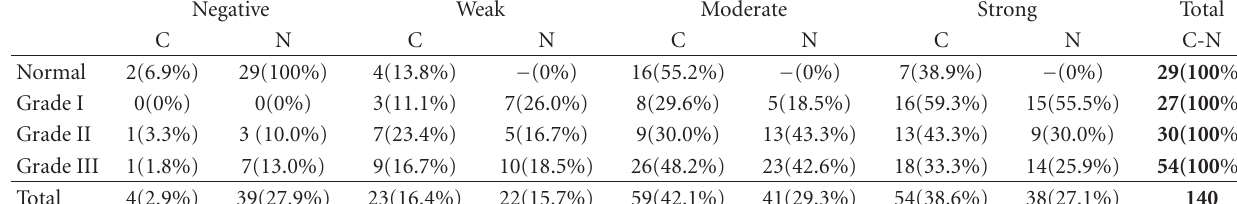
Table 3: Expression of NF κ B, listed separately for cytoplasmic (C) and nuclear (N) localization, in tumor grade of bladder urothelial carcinomas (UC).